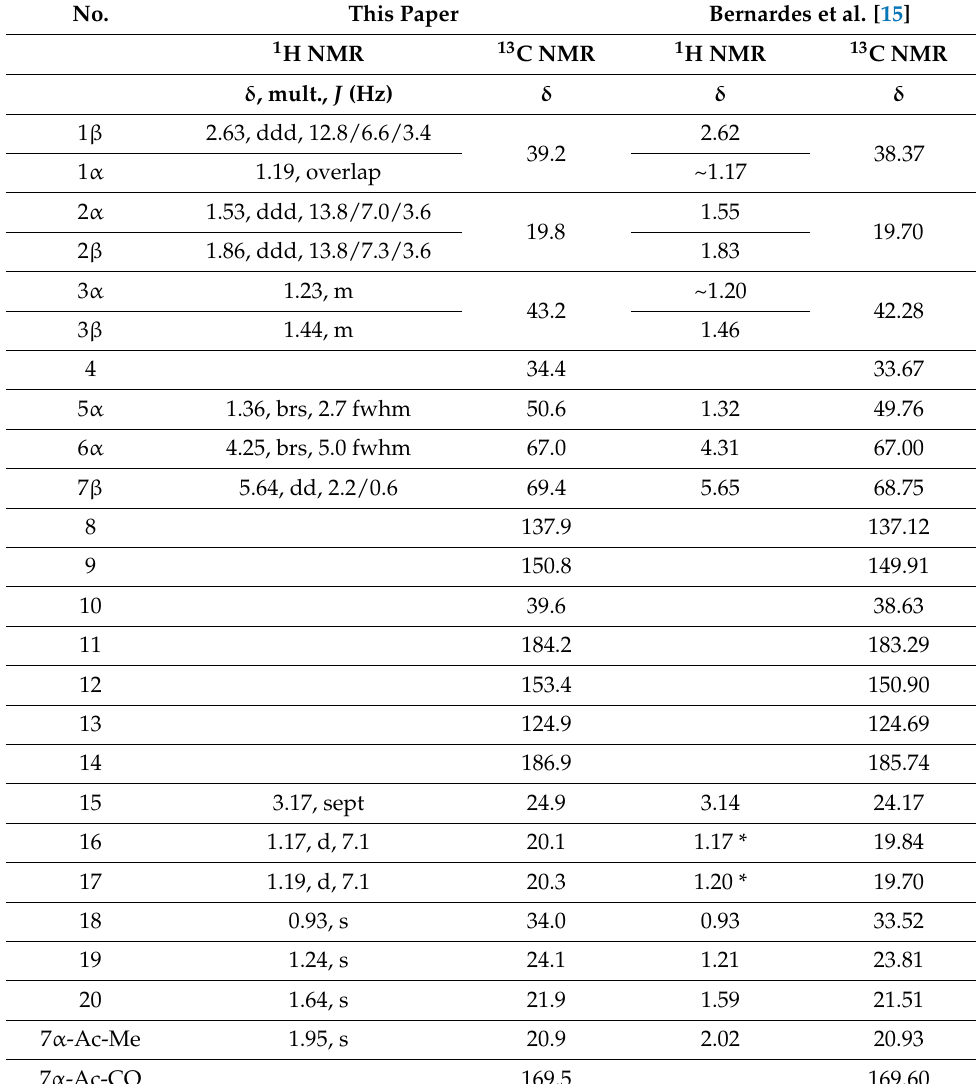
Table A1. NMR data (500 MHz for 1 H; 125 MHz for 13 C) of 7 α -acetoxy-6 β -hydroxyroyleanone reported in this paper (acetone- d 6 ) and by Bernardes et al. (2018) (CDCl 3 ). No. This Paper Bernardes et al.